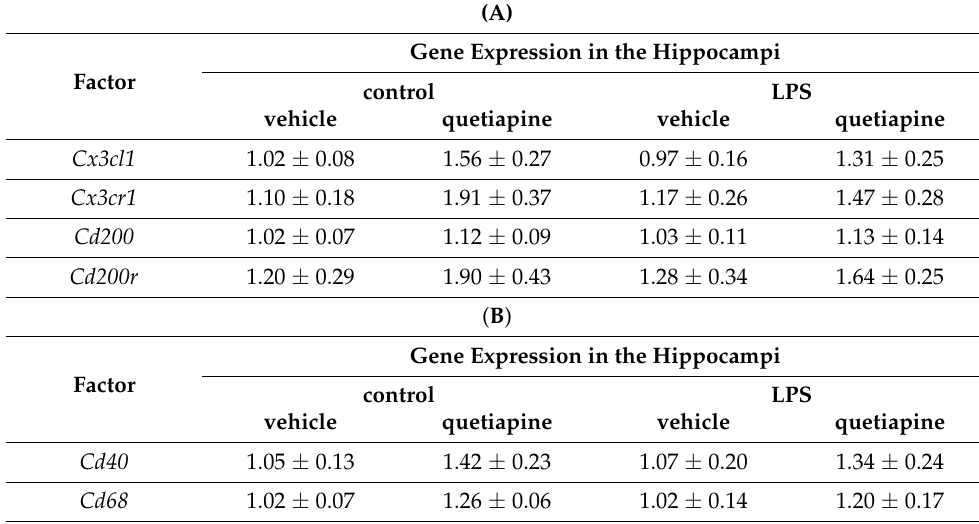
Table 4. The impact of prenatal exposure to LPS and subsequent chronic treatment with quetiapine on the gene expression of Cx3cl1 , Cx3cr1 , Cd200 and Cd200r ( A ) as well as Cd40 , Cd68 , Arg1 and Igf-1 ( B ) in the hippocampi of the offspring. The mRNA levels were measured using qRT-PCR with n = 7–8 in each group. The results are presented as the average fold change ±